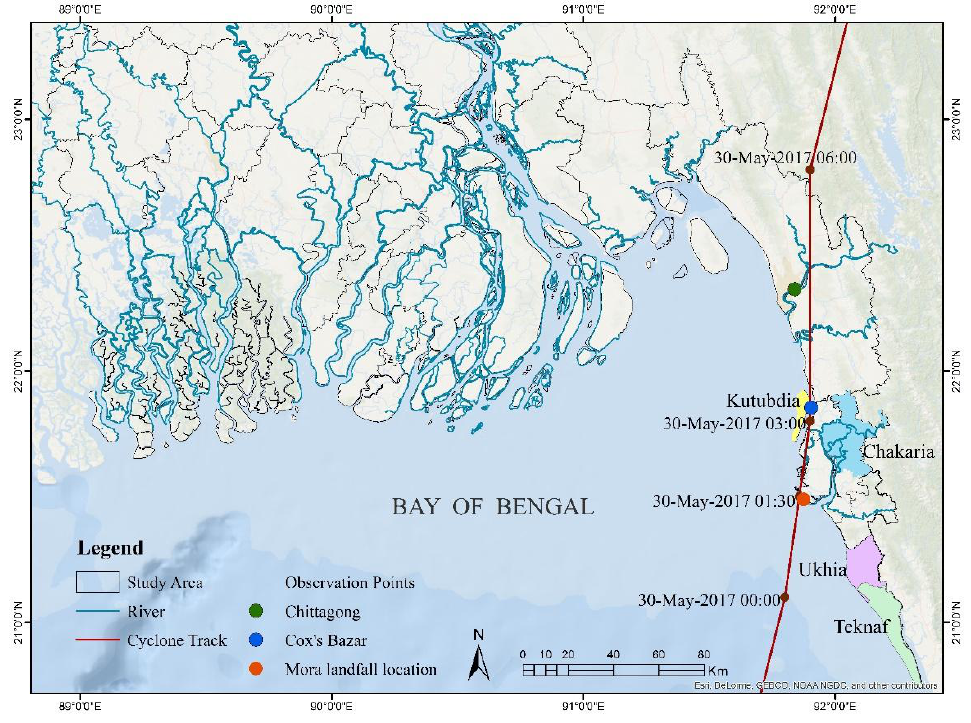
Figure 1. Map of the study area.